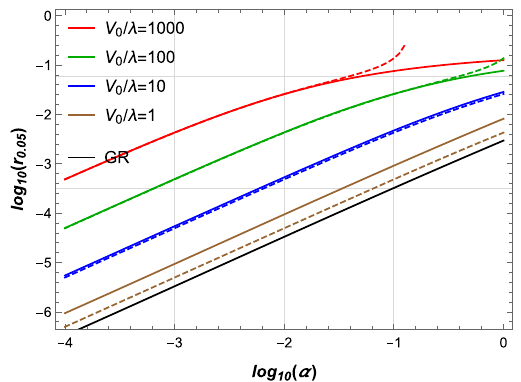
α for different values of V /λ in brane inflation and for α -attractor in 0 general relativity with N = 60. The dashed line denotes the analytical approximation and the solid line corresponds to the numerical result. The upper light gray horizontal line represents the observational upper bound r ≤ 0 . 06 and the lower light gray horizontal line corresponds to the GR result with α = 0 .